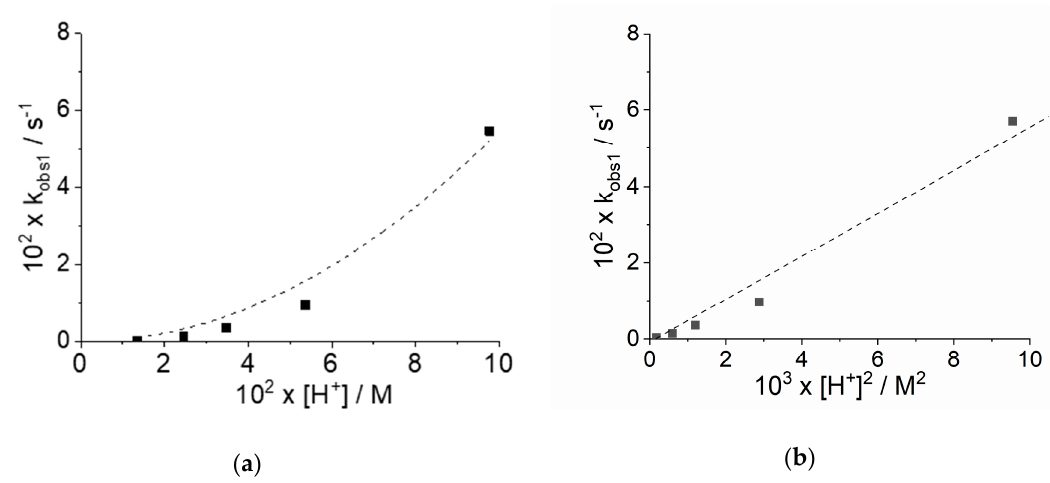
Figure 3. Plot of the pseudo-first order rate k obs 1 (s − 1 ) for the demetallation of ZnTPPS 4 at constant ionic strength as function of ( a ) [H + ] (dashed line is the best fit to the function k obs1 = k 2 [H + ] 2 ) and ( b ) [H + ] 2 (dashed line is the linear fit of the experimental data).